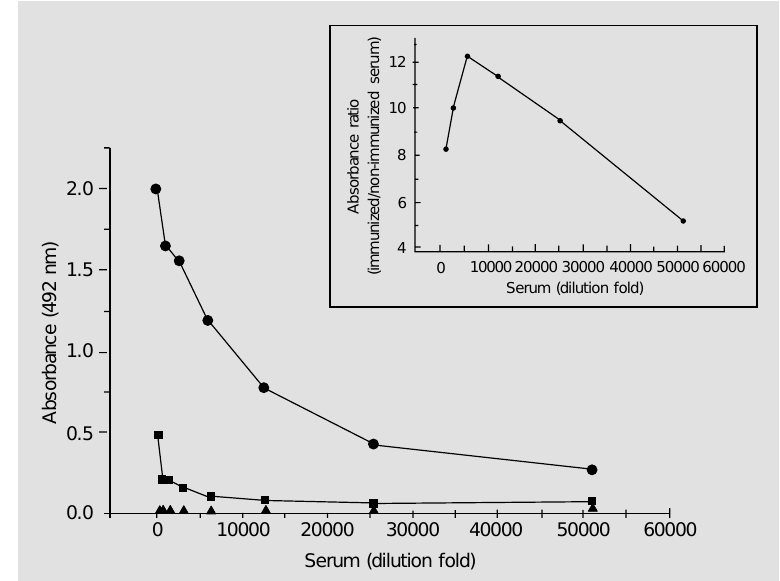
Figure 4 - Comparison of the ab- sorbance values obtained by conventional ELISA based on polyvinyl chloride (PVC) and ELISA based on filter paper plas- ticized with polyvinyl alcohol-glu- taraldehyde. Sera from immu- nized (N = 8) and non-immu- nized (N = 9) rabbits were ana- lyzed for the presence of anti-F1 antigen IgG. The absorbance re- ported is the mean of two deter- minations. The arrows indicate the positions of the mean val- ues.